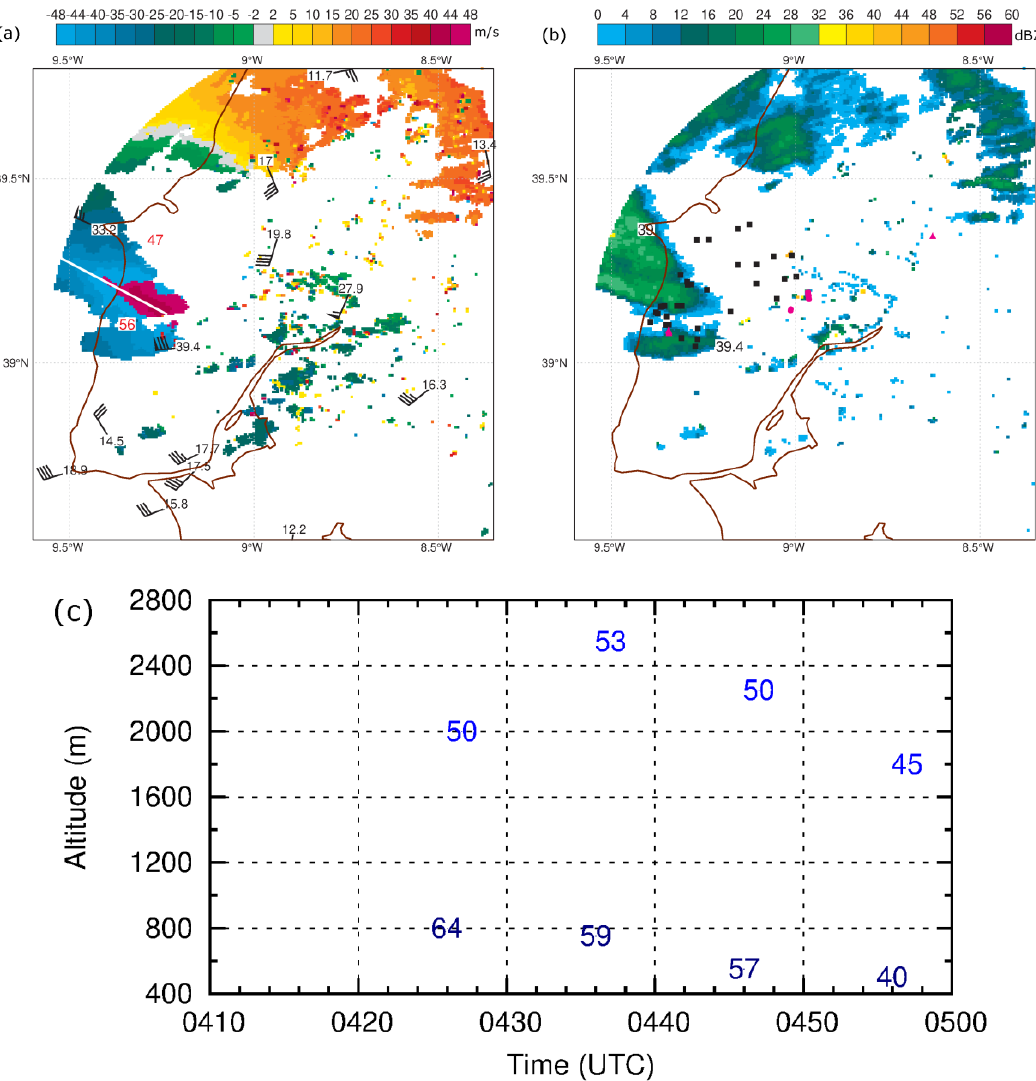
Figure 14. ( a ) CL radar PPV (0.1 ◦ elevation) showing the jet streak signature (axis denoted by white line) at 04:36 UTC, and wind gust at 04:40 UTC (black barbs and value in m s − 1 ), at IPMA stations. The maximum wind speed (m s − 1 ) at two other stations (not IPMA) is represented in red. ( b ) PPZ (0.1 ◦ elevation) showing the reflectivity field of the cloud head tip. The locations of the damages to power towers (between 04:34 UTC and 04:48 UTC) are marked with magenta triangles (concrete and steel) and circles (steel part), and damages to other structures are marked with black squares. The locations of maximum gusts of 39.4 m s − 1 (between 04:30 UTC and 04:40 UTC) and 39 m s − 1 (between 04:40 UTC and 04:50 UTC) recorded at IPMA stations is also marked. ( c ) Total wind speed values (m s − 1 ) computed in the period from 04:20 UTC to 05:00 UTC on 23 / 12 / 2009. Maximum values are presented for 0.1 ◦ elevation (in dark blue) and 1.5 ◦ elevation (in blue).